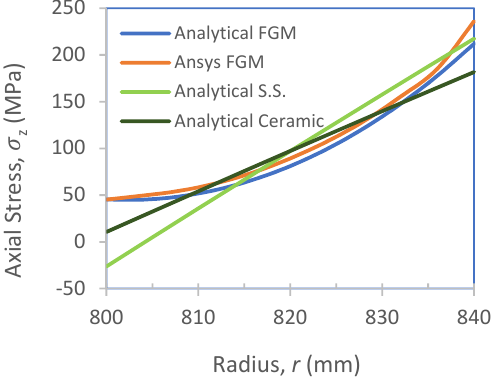
Figure 9. The variation of axial stress with cylinder radius.